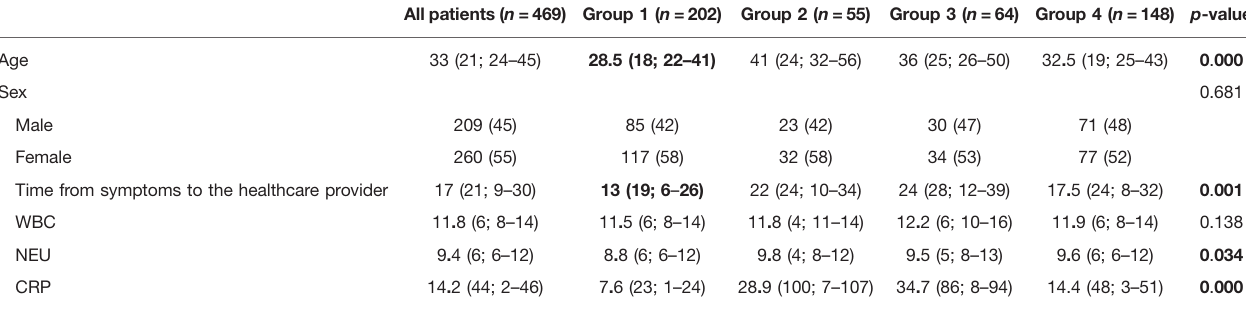
TABLE 1 | Cohort of suspected acute appendicitis.